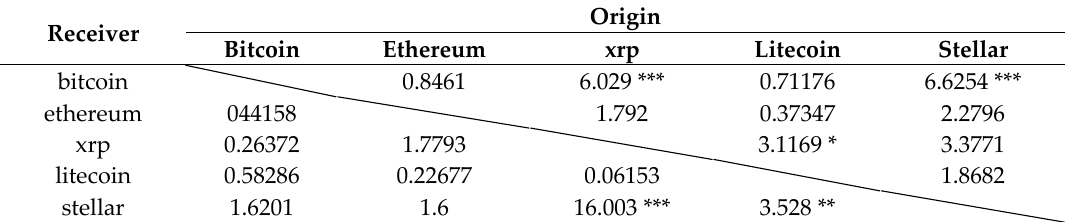
Table 5. Structural Vector Autoregression (SVAR) Granger causality results.